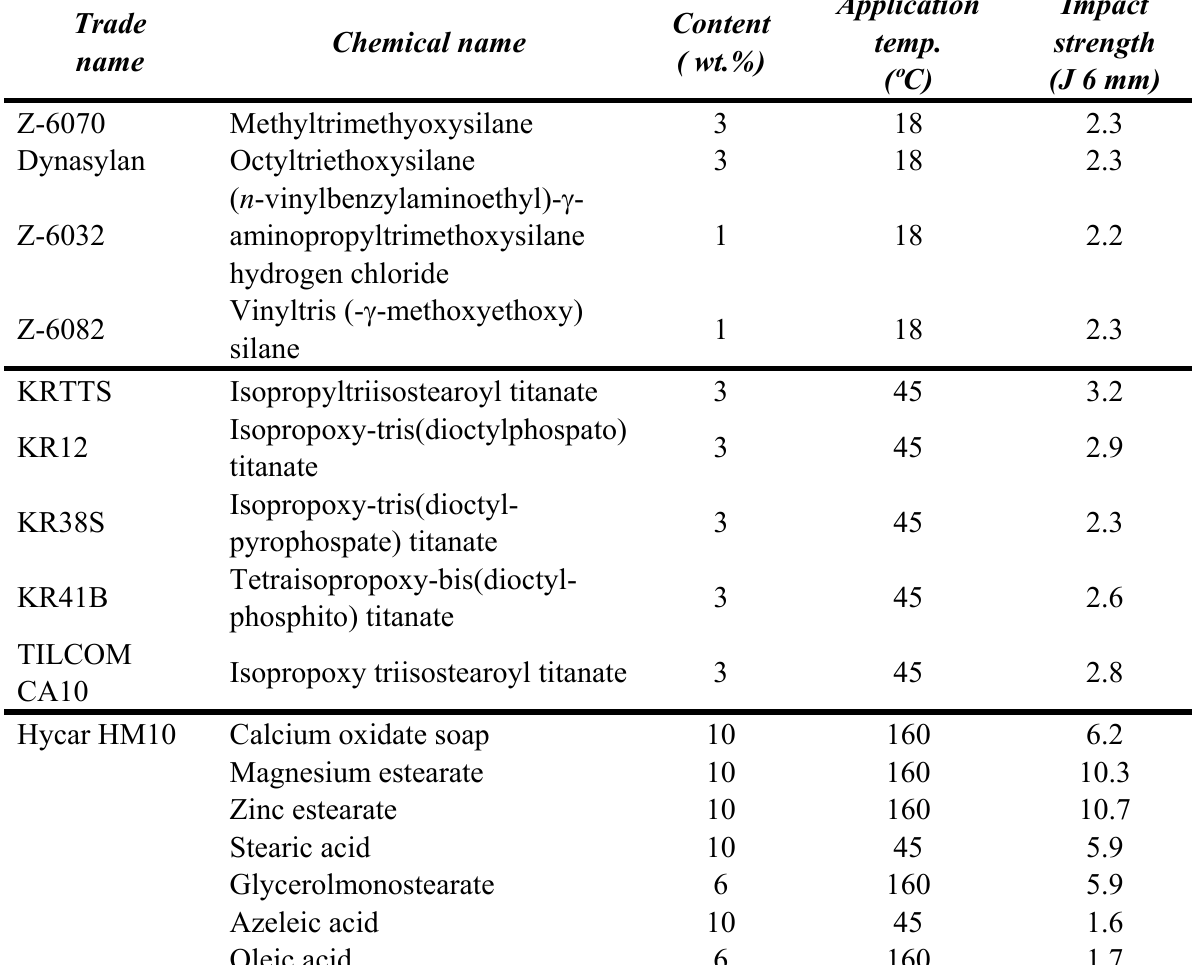
Table 7. Impact strength obtained from falling weight tests on PP/Mg(OH) containing 50 wt.% of particles with several surface treatments (adapted from